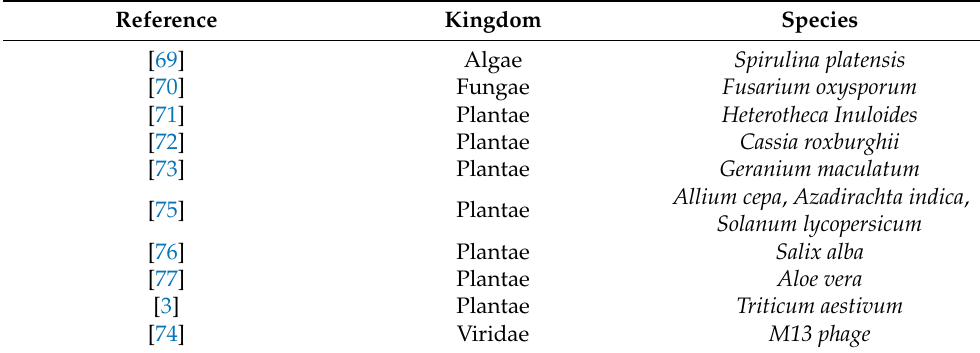
Table 2. Species used for the biosynthesis of silver